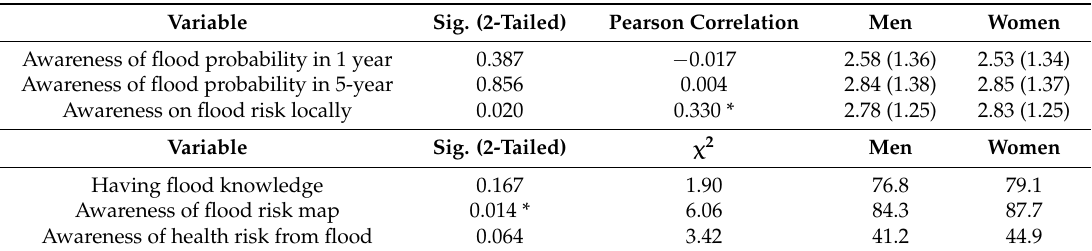
Table 5. Pearson correlation and Chi-square test results between risk awareness and gender. Standard deviations are shown in